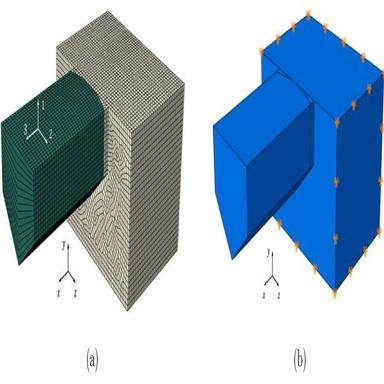
Finite element model of single microcantilever beam geometry with the mesh highlighted (a) and sketch of the boundary condition applied to the matrix block (b).